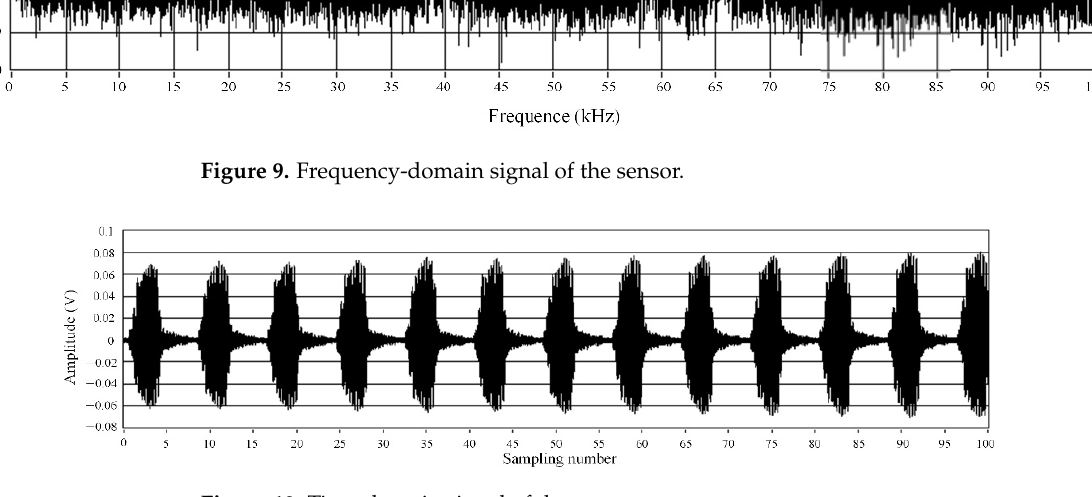
Figure 10. Time-domain signal of the sensor.